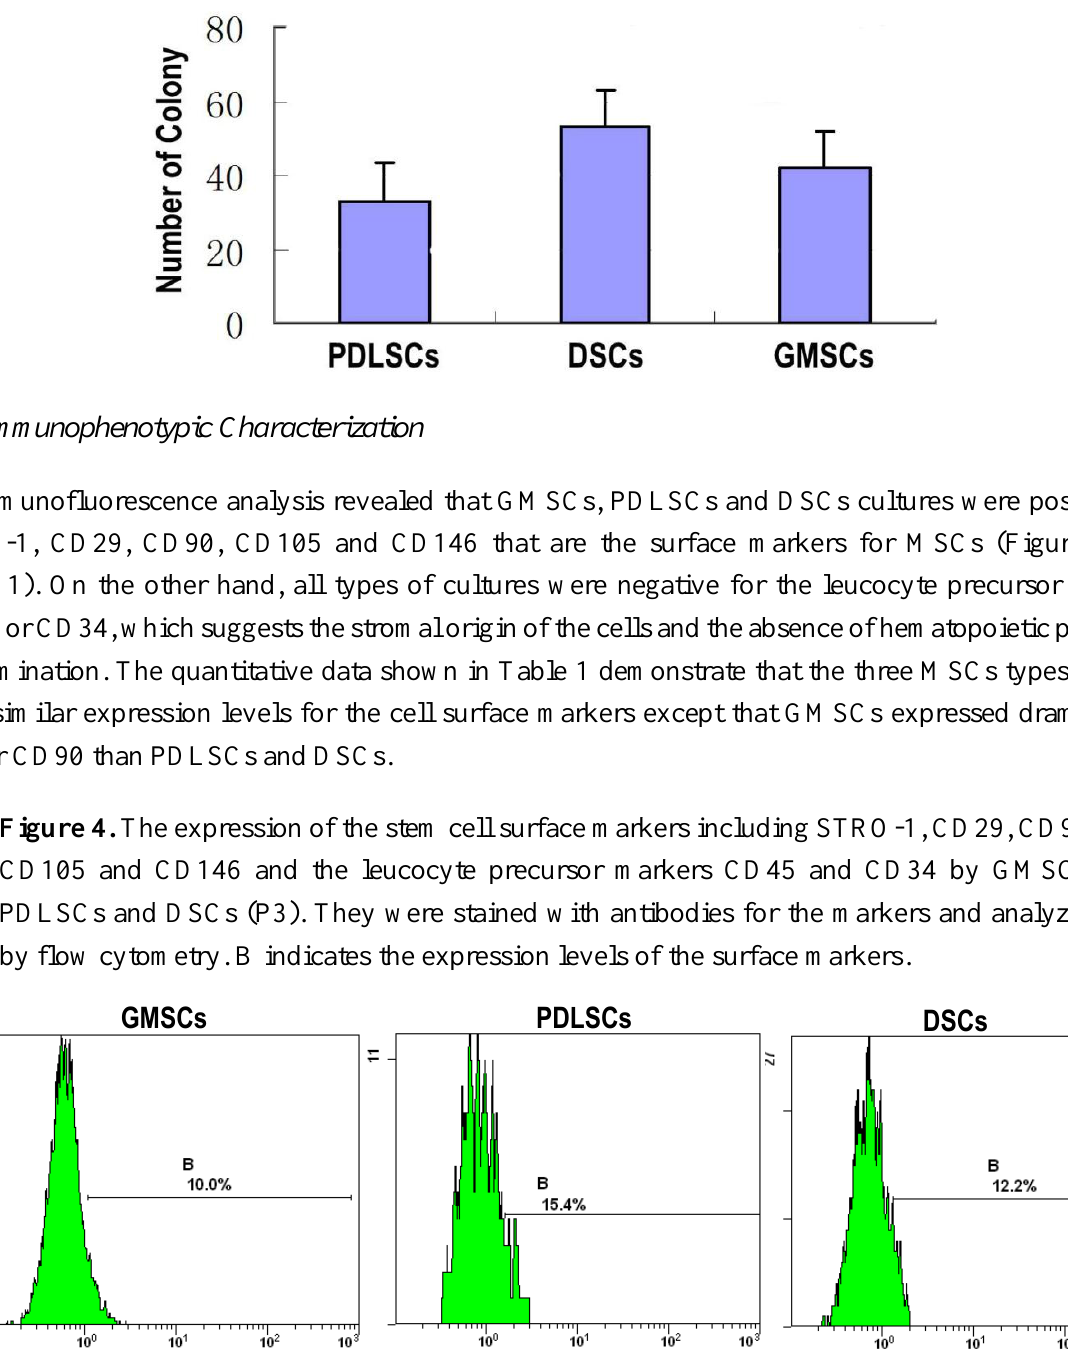
Figure 3. The number of colony generated by GMSCs, PDLSCs and DSCs (P3). The single P3 cell suspensions were seeded in 10 cm culture dishes in α-MEM (10% fetal bovine serum (FBS)) at a density of 1 × 10 3 cells/well and cultured for 14